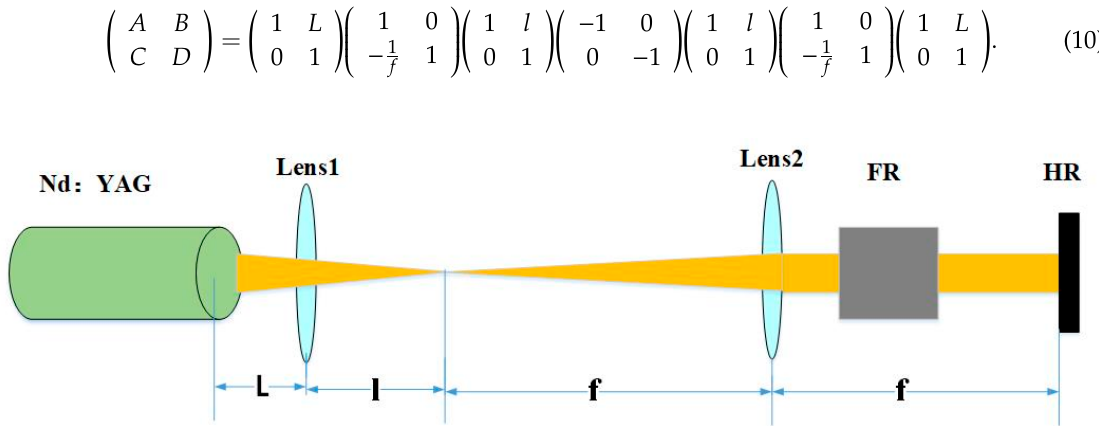
Figure 6. The structure for depolarization compensation in a single-rod amplifier.